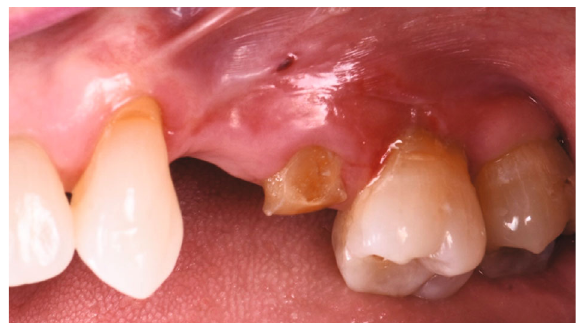
Figure 3: Improved soft tissue response to topical corticosteroid therapy two months after